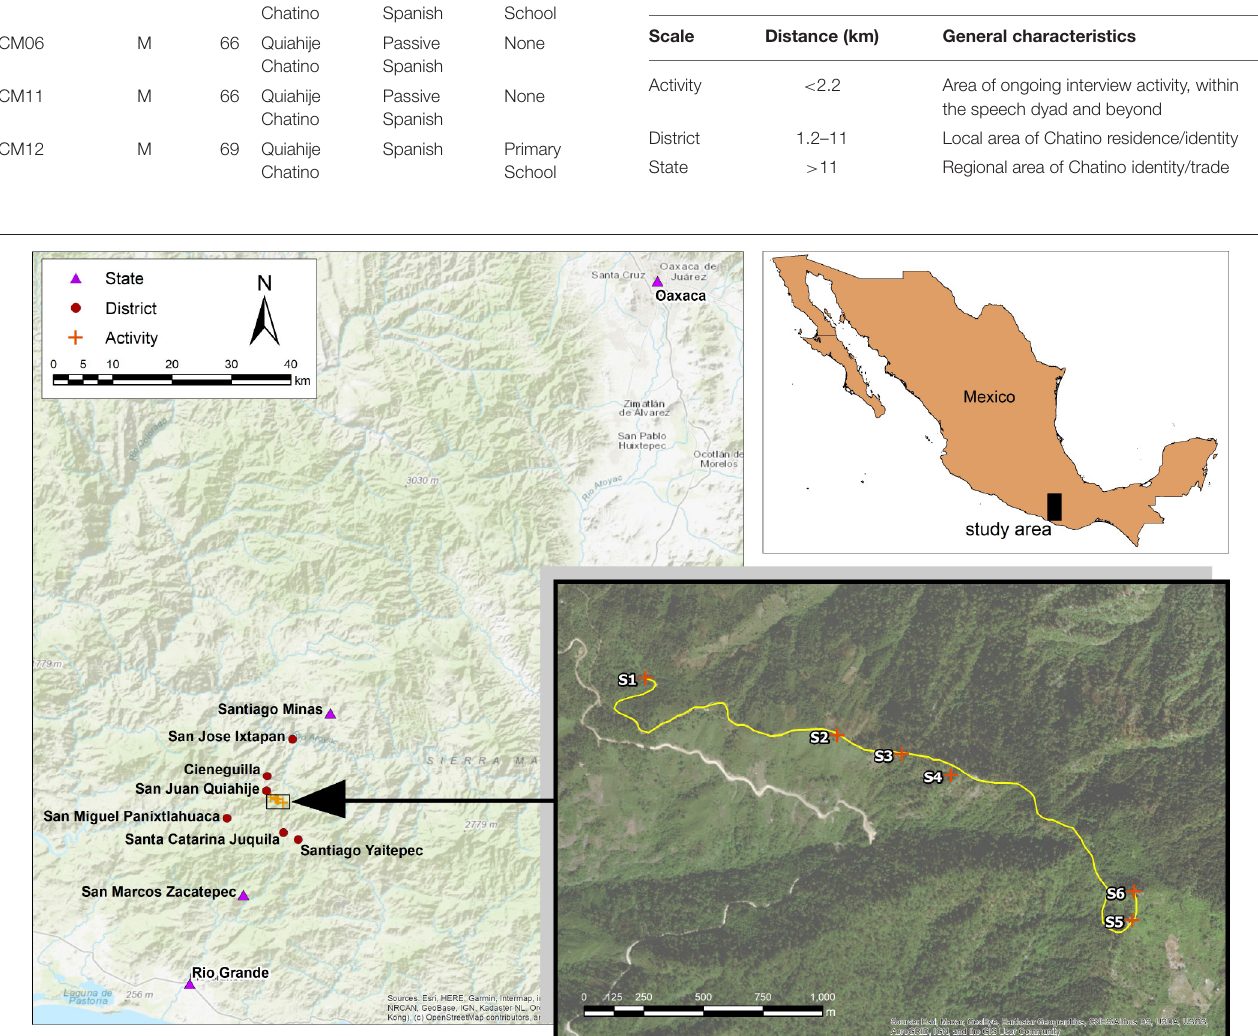
FIGURE 1 | Targets discussed by interview participants at six different locations along the trail.